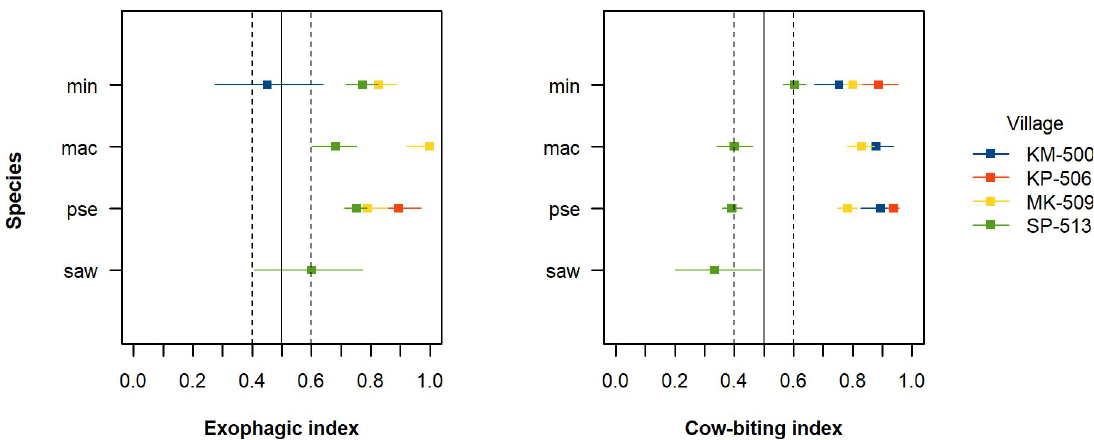
Fig 1. Exophagic and cow-biting index estimates of malaria mosquitoes at baseline. EI and CBI were not estimated if the total number of collected mosquitoes was less than 15 for the corresponding index. Error bars indicate exact binomial 95% CIs. Abbreviations : CBI, cow-biting index; CI, confidence interval; EI, exophagic index, pse: An . pseudowillmori , mac, An . maculatus ( s . s .) min, An . minimus ( s . s .), saw: An . sawadwongporni .